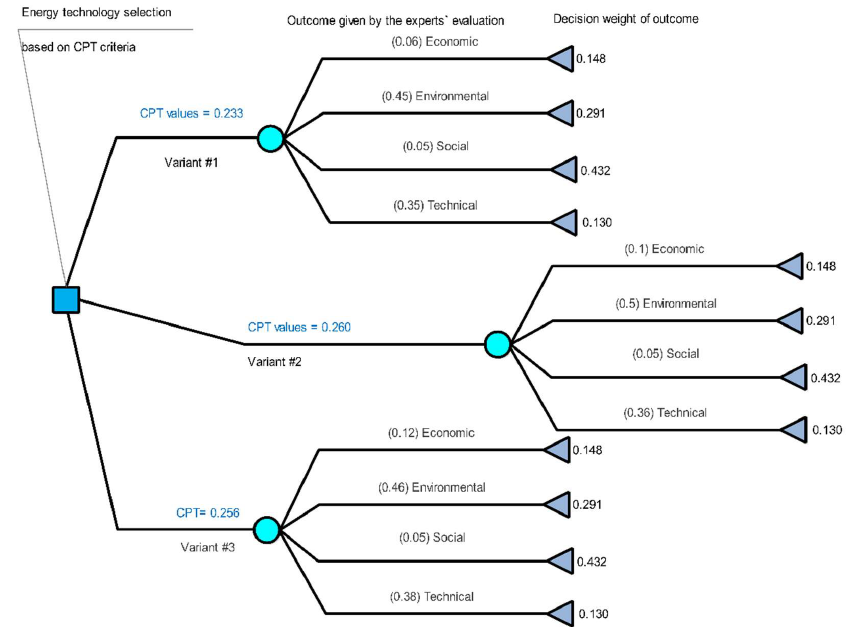
Figure 7. Decision tree.